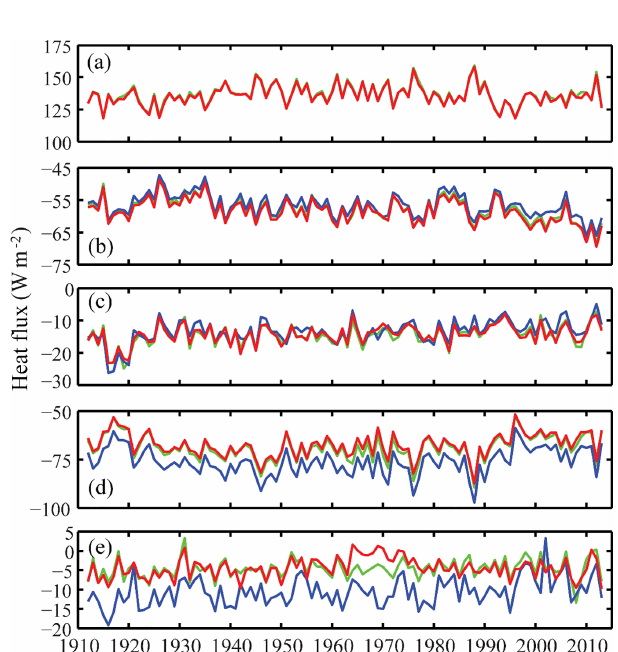
Figure 7. Yearly average (a) radiation flux, (b) longwave radiative flux, (c) sensible heat flux, (d) latent heat flux, and (e) total heat flux at the lake surface for Lake Mendota (solid black line), Fish Lake (black dashed line), and Lake Wingra (solid gray line). Trends and abrupt changes for heat fluxes are not shown on the plots for